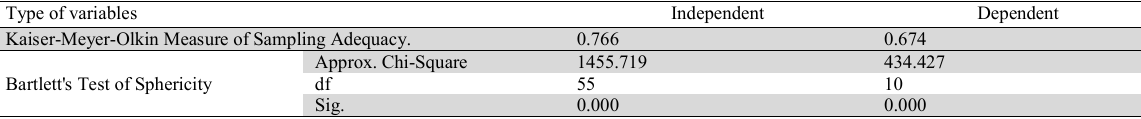
KMO and Bartlett’s Test Type of variables Independent Dependent Kaiser-Meyer-Olkin Measure of Sampling Adequacy.